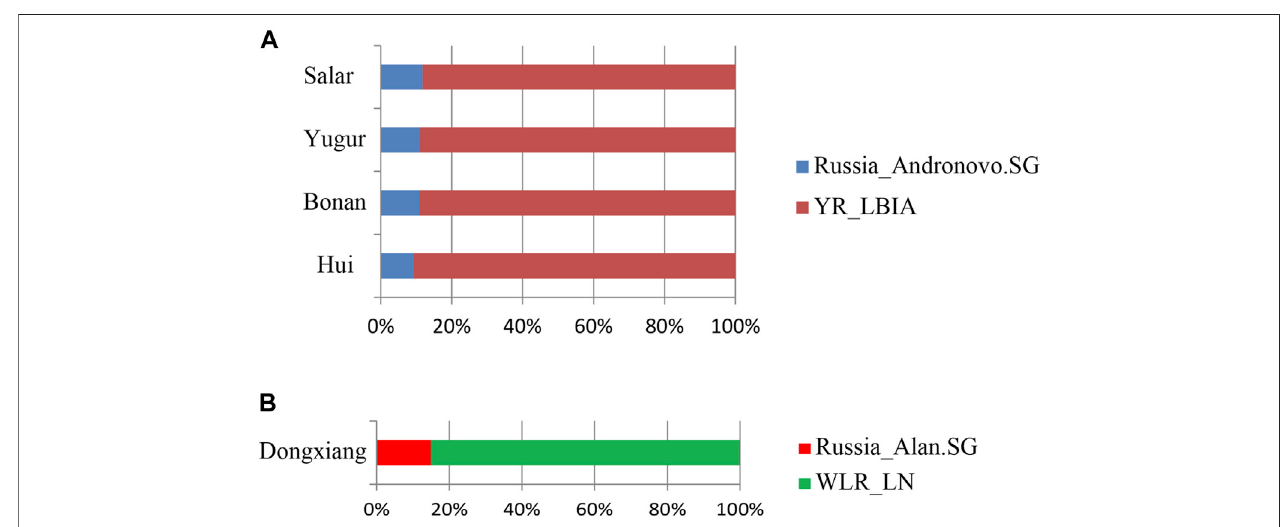
FIGURE 8 | qpAdm based admixture models for the populations in our study in Gansu province. The 2-way admixture models for our Gansu samples were presented when the p values > 0.05 at the rank (cid:1) 1. (A) Hui, Bonan, Yugur, Salar ethnic groups. (B) Dongxiang ethnic